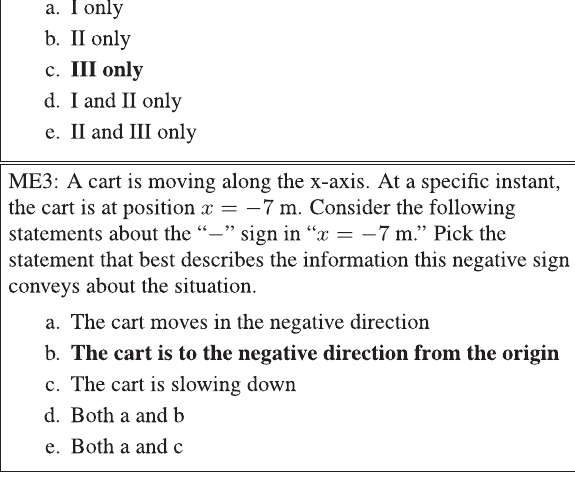
FIG. 2. Examples of a multiple-choice questions probing student understanding of signed quantities. ME1 is an example of a positive-quantity question, while ME2 and ME3 are negative-quantity questions. Correct answers are bolded.